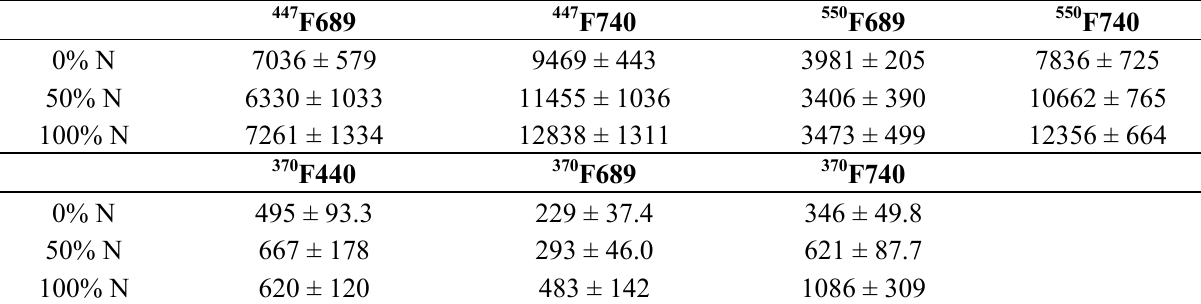
Table 3. Fluorescence values of barley leaves ( Hordeum vulgare L.) grown under 0%, 50%, and 100% nitrogen supply (N). The samples were excited with UV-A (370 nm), blue (447 nm) or green light (550 nm), and detected at three bands (440, 689 and 740 nm). The average fluorescence values were calculated from the middle part of the images (integrated values of all the pixels). The values (± SD) are the result of eight barley leaves for each